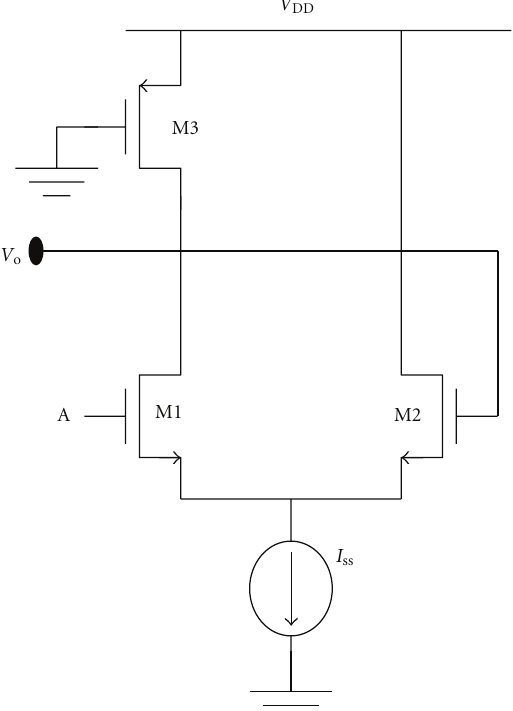
Figure 1: Basic PFSCL inverter/bu ff er.